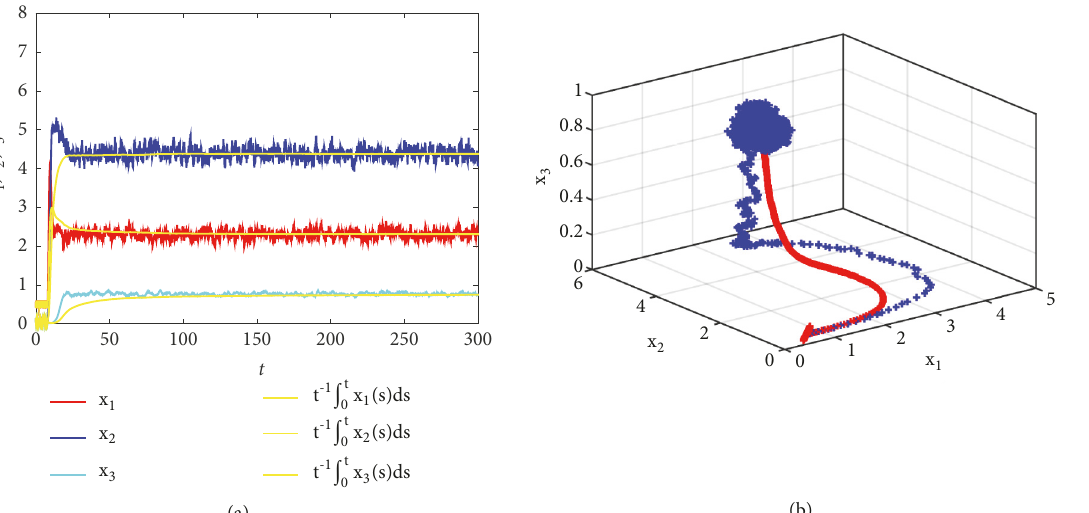
Figure 4: The persistence in mean of two preys and of three species are given in Theorem 11. (b) stands for the phase portrait of (a). The density of white noises is taken: 𝜎 1 = 0.8, 𝜎 2 = 0.65, 𝜎 3 = 0.42 .